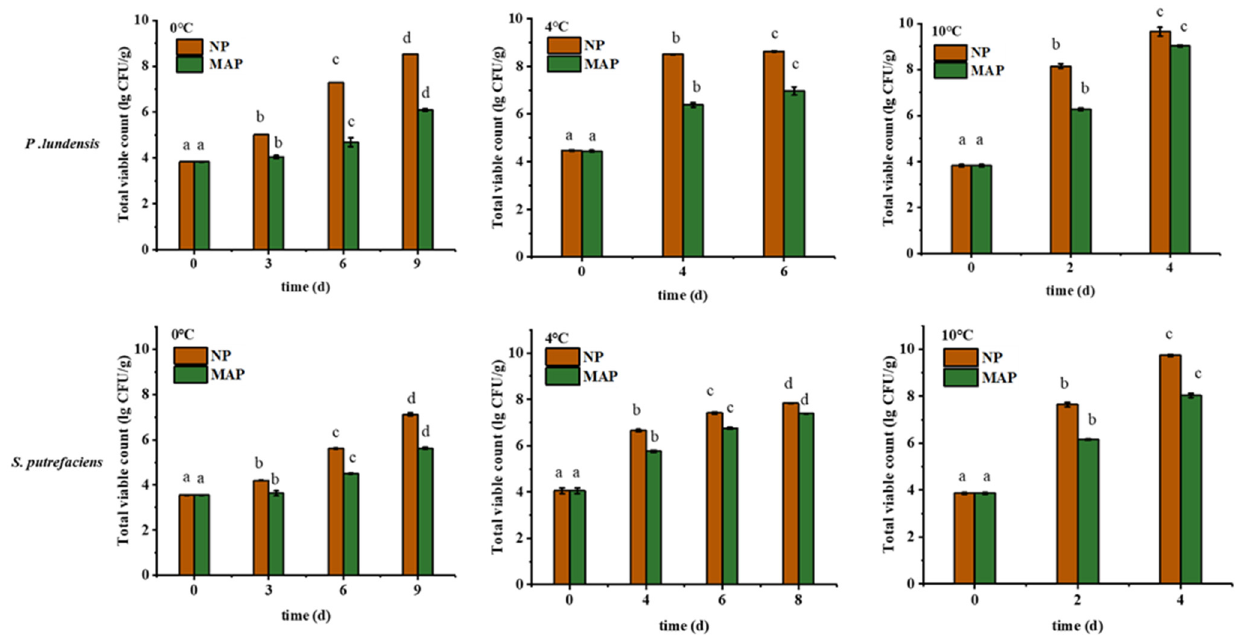
Figure 1. Growth of P. lundensis and S. putrefaciens in chilled chicken at 0 °C, 4 °C, and 10 °C. Lowercase letters: significance of dominant spoilage bacteria at different storage times.